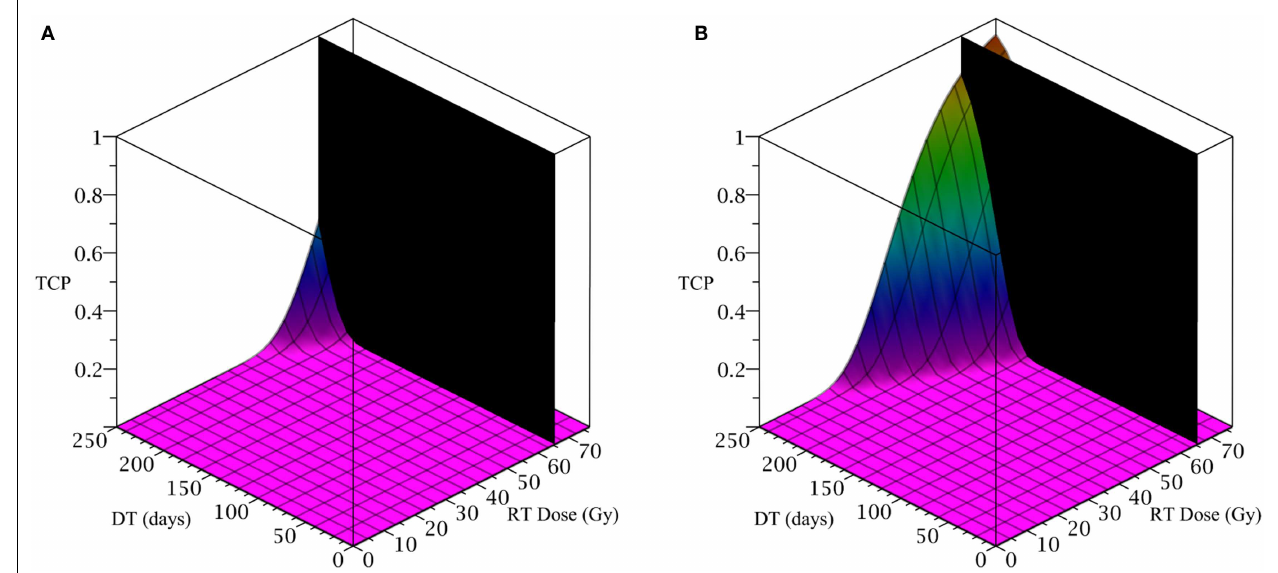
sensitivity to DT, ψ = 5.Thus, the probability of CSC self-renewal, p > 0 . 25. (B) Simulations with ψ = 50.Thus, p > 0 . 205.We do not include graphs for simulations with ψ = 0 . 5 or ψ = 2, as they result inTCP ≈ 0 for all treatment regimens